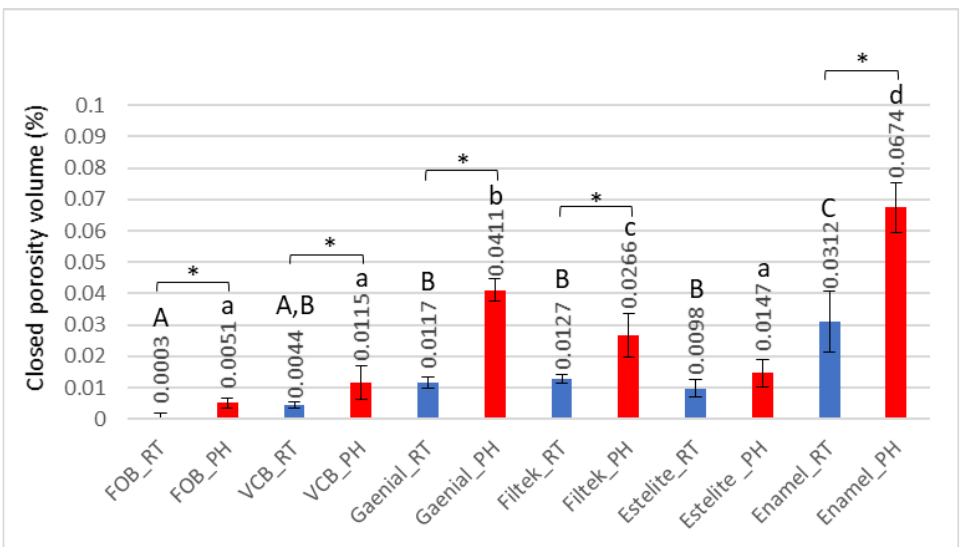
Figure 1. Closed-porosity volume (%) of the room temperature and pre-heated samples analyzed with micro-computed tomography. Different letters denote statistically significant differences among the materials analyzed by one-way analysis of variance (ANOVA) and Tukey ’ s post hoc test. The * mark indicates statistically significant differences between the room-temperature (RT) and pre-heated (PH) groups according to the independent two-tailed t -test.